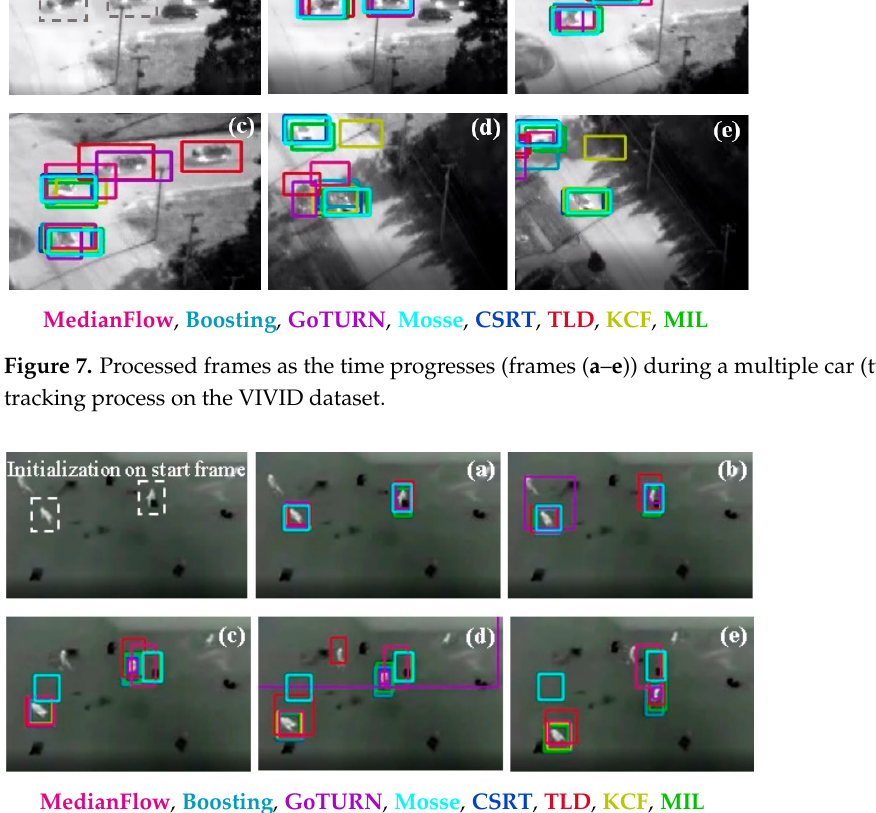
Figure 8. Processed frames as the time progresses (frames ( a – e )) during a multiple person (two objects) tracking process on the LITIV2012 dataset.